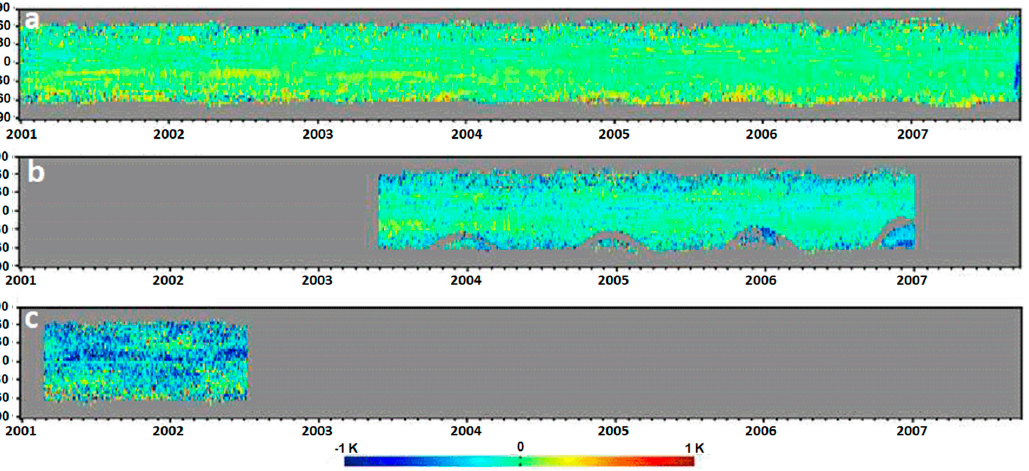
Figure 11. Hovmöller diagrams (latitude vs. time) of nighttime N16 − (D + TM) SST ( a ) RAN2 ‘sub- skin’, ( b ) CCI ‘skin’ + 0.17 K; ( c ) PF ‘skin’ + 0.17 K. (Data are from the NOAA SQUAM system [21,22]).